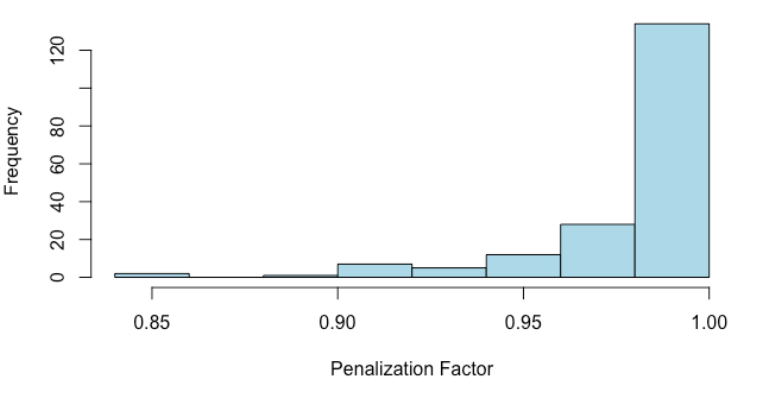
Figure 2. Distribution of the penalization factor.